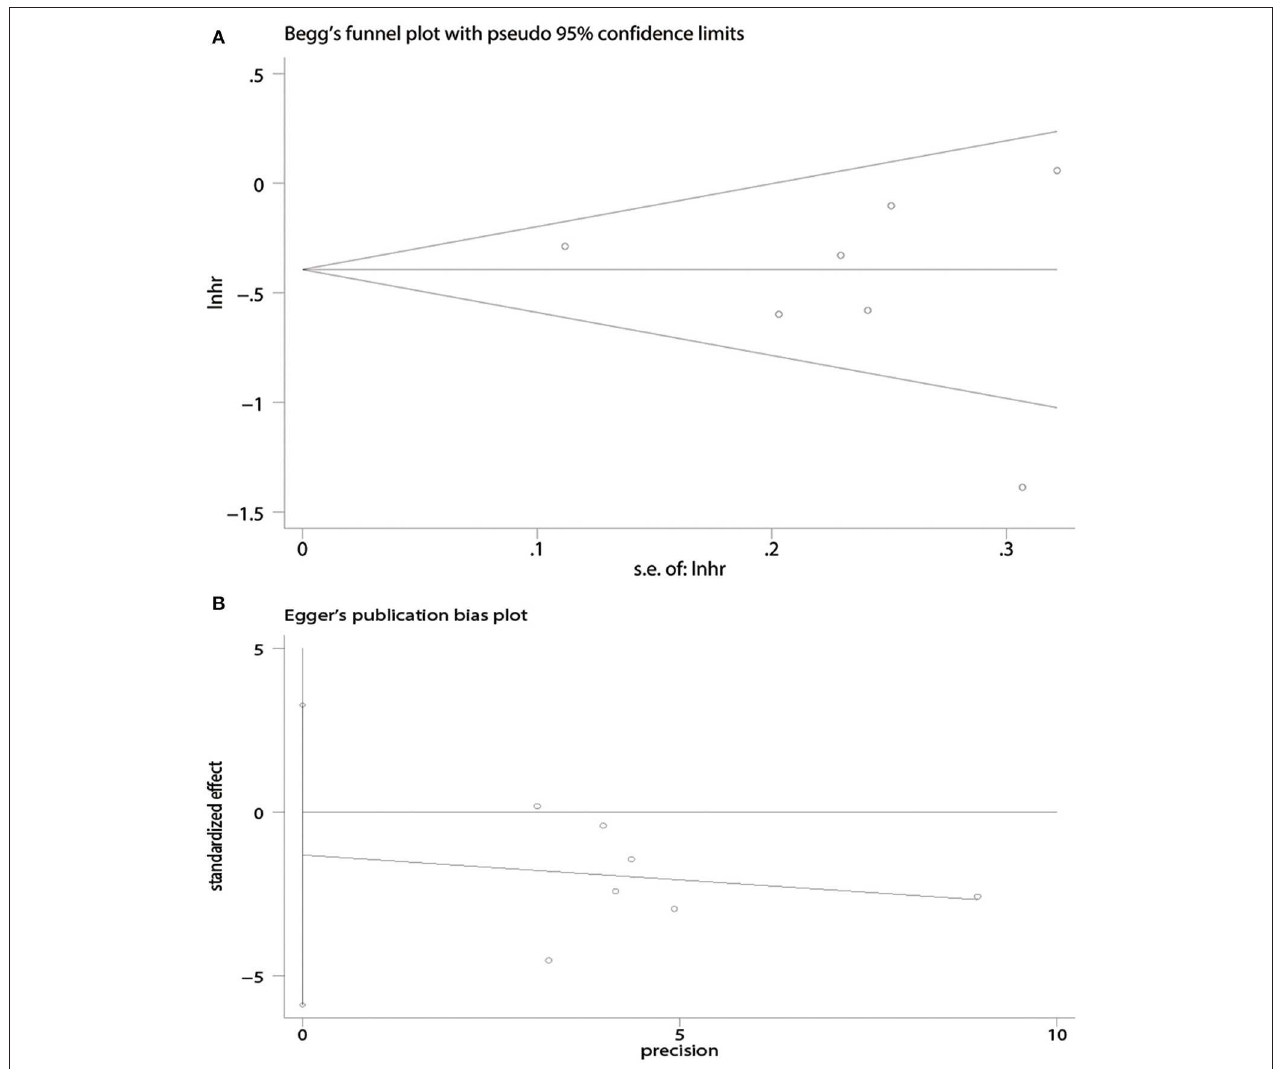
FIGURE 4 | Publication bias for overall survival (OS) analysis. (A) Begg’s test. (B) Egger’s